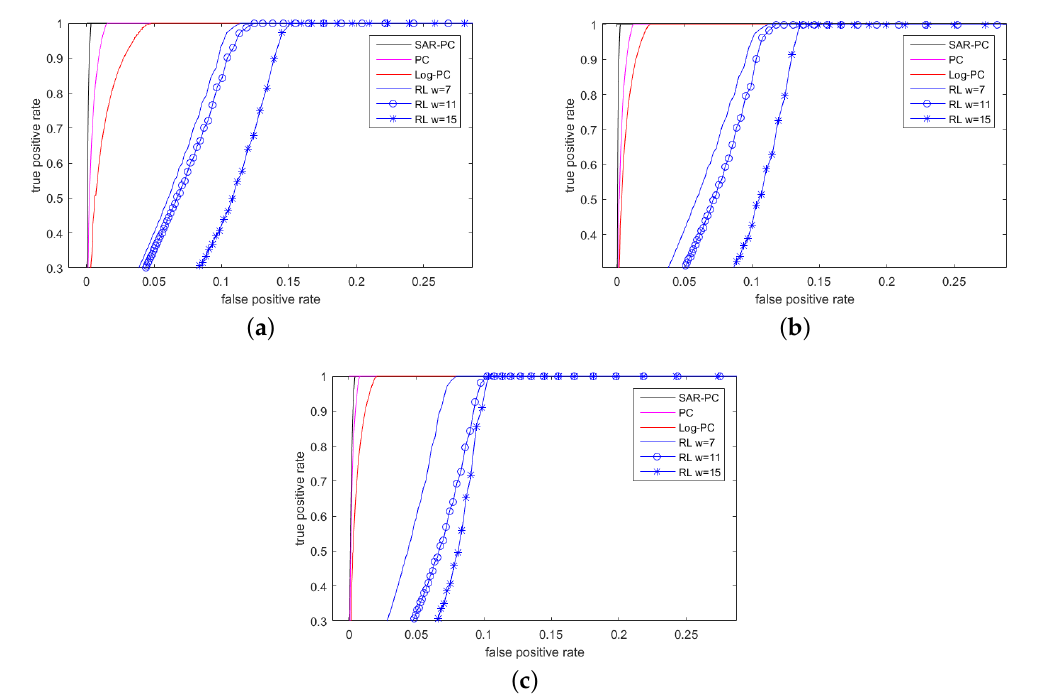
Figure 11. ( a ) ROC curves on one-look simulated SAR image (Roof); ( b ) ROC curves on three-look simulated SAR image (Roof); ( c ) ROC curves on six-look simulated SAR image (Roof).